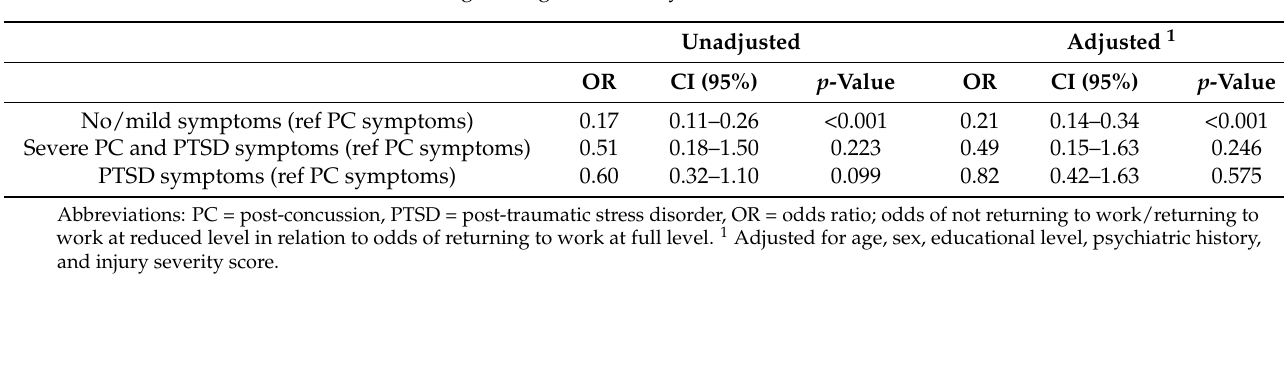
Table A5. Logistic regression analysis on 6-month return to